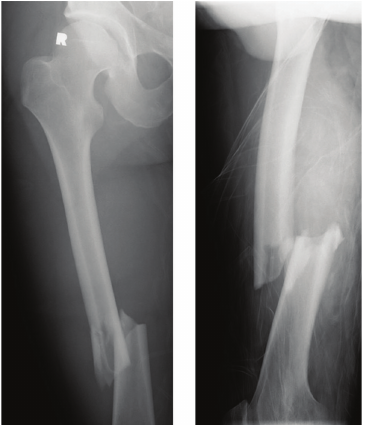
Figure 2: Anteroposterior CT scout image of the right femur. The cortical widths of the medial proximal and distal fragments appear to be